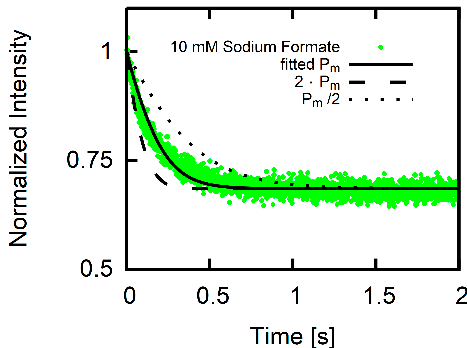
Figure 5. Sensitivity of the fit to P m . Fluorescence trace for 10 mM sodium formate and 10 mM MES (middle trace of middle panel in Figure 4) together with the result of the fitting procedure (solid black line). Curves for double (dashed black line) or half (dotted black line) the fitted P m reveals that the algorithm calculates traces sensitive for changes in P m .